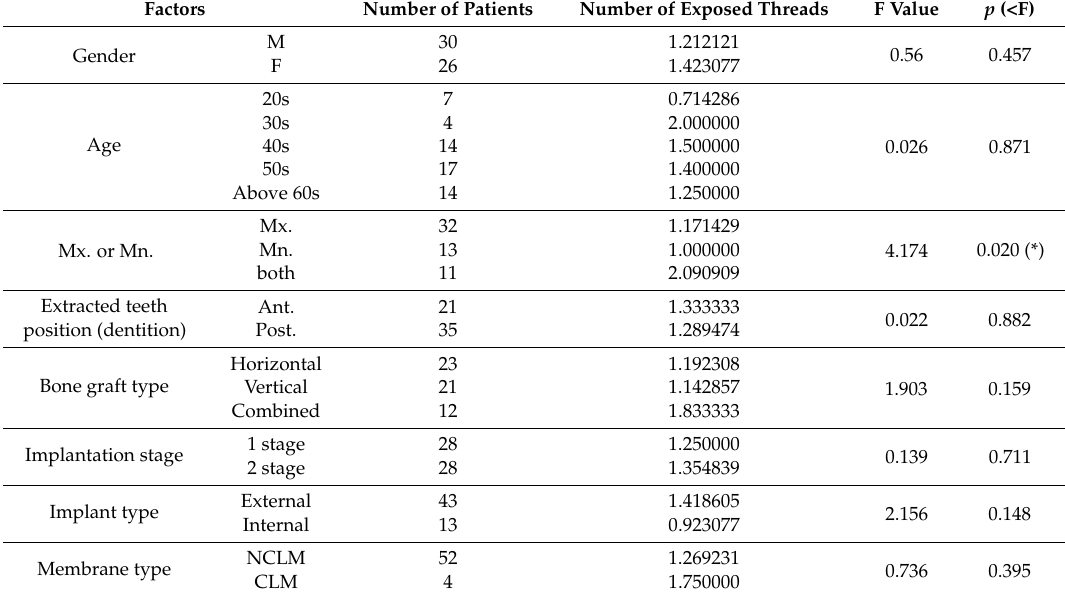
Table 1. The numbers of exposed implant threads in each factor. (Abbreviations; Maxilla: Mx., Mandible: Mn, Non-cross-linking membrane: NCLM, Cross-linking membrane: CLM, * p < 0.05) Factors Number of Patients Number of Exposed Threads F Value p (<F) M 30 1.212121 Gender